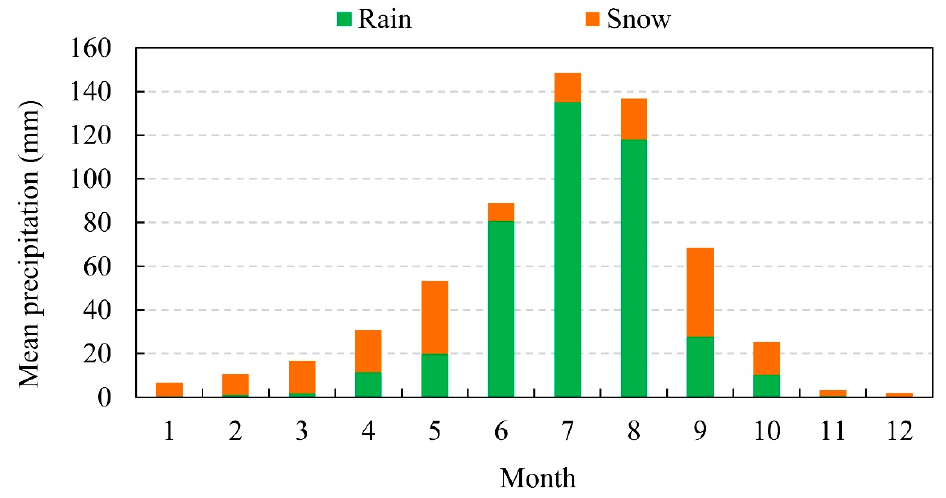
Figure 4. Multi-year (2001–2010) monthly mean and basin mean precipitation types (rain and snow) for the upper basin above Nuxia gauging station. The precipitation data are from the TRMM dataset.